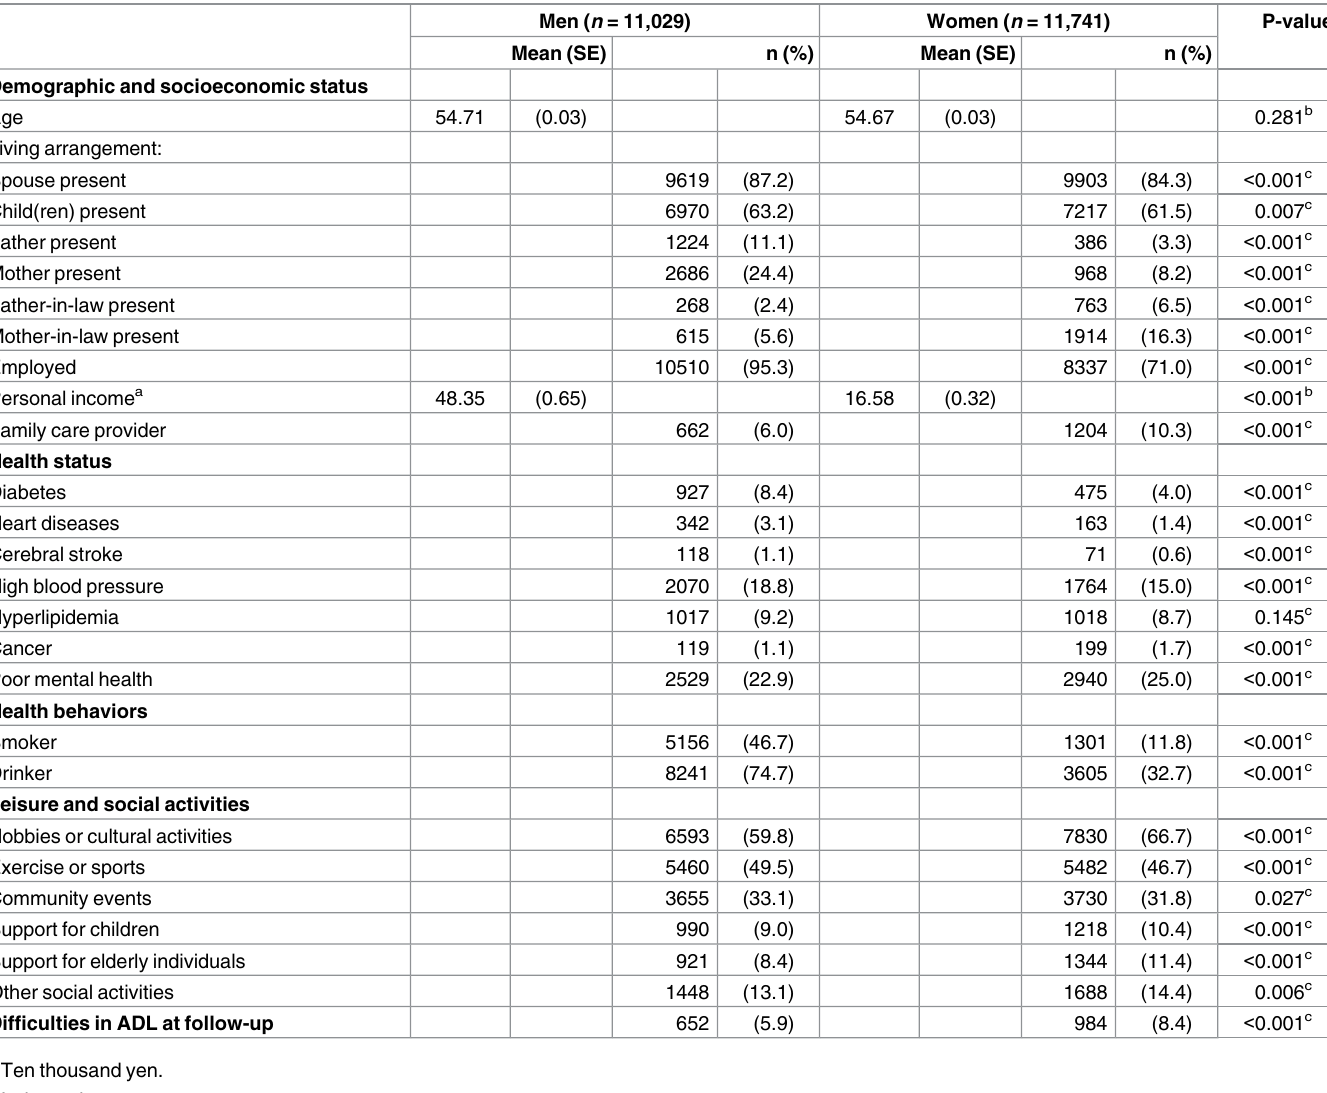
Table 1. Characteristics of respondents after multiple imputation of missing